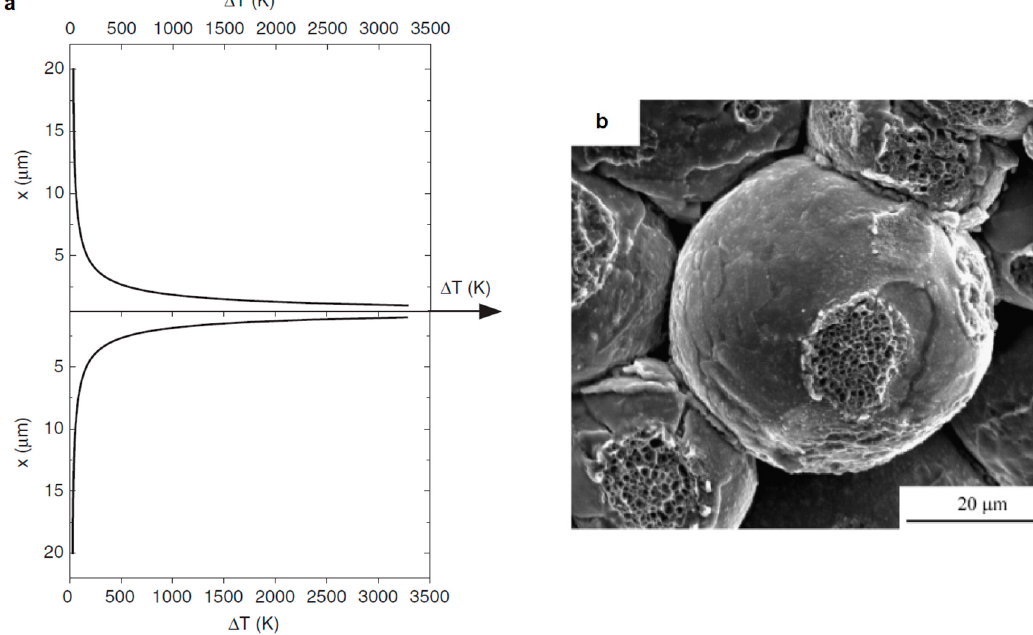
Figure 3. ( a ) Calculated temperature distribution along the line connecting the centers of two copper particles (the current passing through the sample was 1000 A, the sample diameter was 20 mm, the copper particle diameter was 20 µ m), ( b ) the morphology of the fractured neck between the copper particles (SPS at 660 ◦ C, 20 MPa, the relative density of the sample was 80.1%). Reprinted from Song et al. [29], Copyright (2005), with permission of John Wiley & Sons.